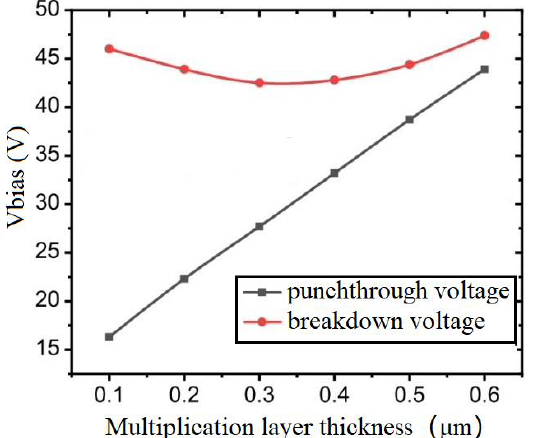
Figure 7. The change in punchthrough voltage and breakdown voltage with the multiplication layer thickness (the breakdown voltage is set at the position where the dark current is 10 − 5 A).